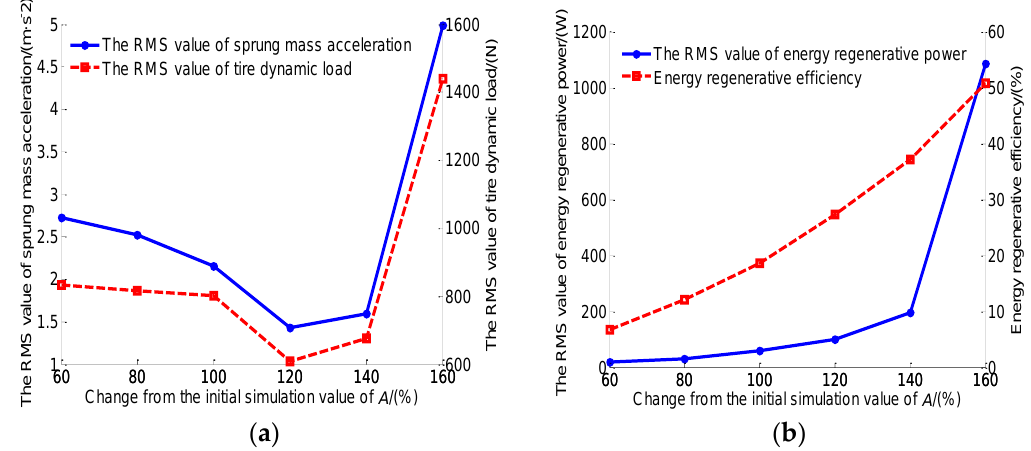
Figure 6. Influence of the effective area of the hydraulic cylinder piston on evaluation indicators: ( a ) Influence of the effective area of the hydraulic cylinder piston on the damping performance; ( b ) Influence of the effective area of the hydraulic cylinder piston on energy regenerative performance.